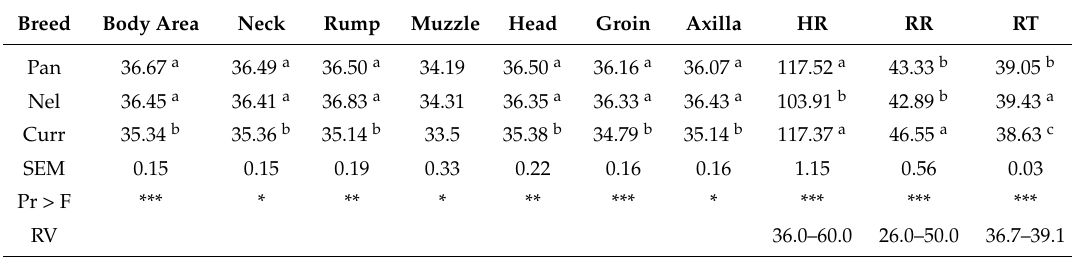
Table 1. Surface temperatures and physiological parameters of the